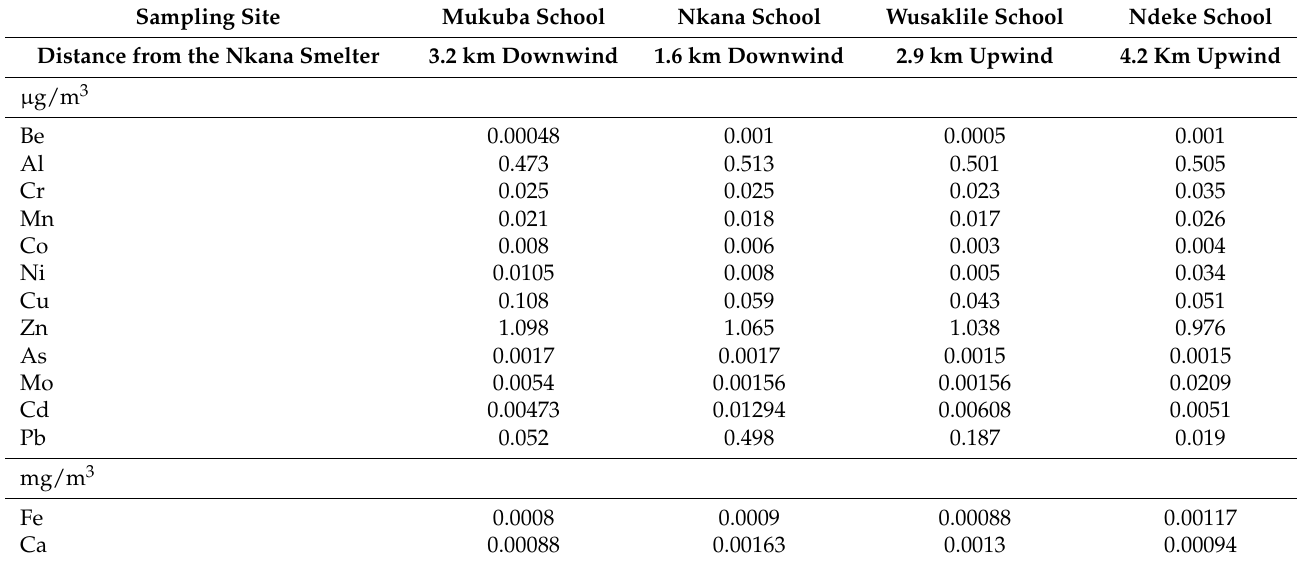
Table 1. The chemical composition of the dust fall in the Mukuba, Nkana, Wusalile and Ndeke schools in Kitwe (average data, n = 7), Zambia. The Mukuba High School is located 3.2 km downwind of the Nkana Smelter, the Nkana High School 1.6 km downwind of the smelter. The Wusakile and Ndeke schools are located upwind of the Nkana Smelter. For location of sampling sites, see Figure 5. The dust fall was monitored from 21 July to 27 July 2005 by portable samplers. Sampling was carried out in cooperation with the staff of the individual schools. The concentration of trace elements is in µ g/m 3 of normalized air, concentrations of Fe and Ca are in mg/m 3 . After Kˇr í bek and Nyambe